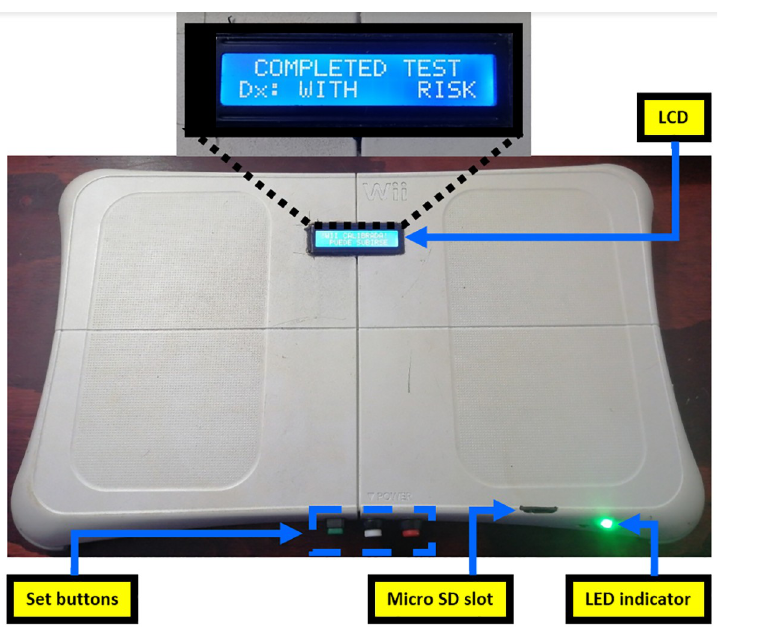
Fig 1. Modified Wii Balance Board (MWBB) to estimate a balance